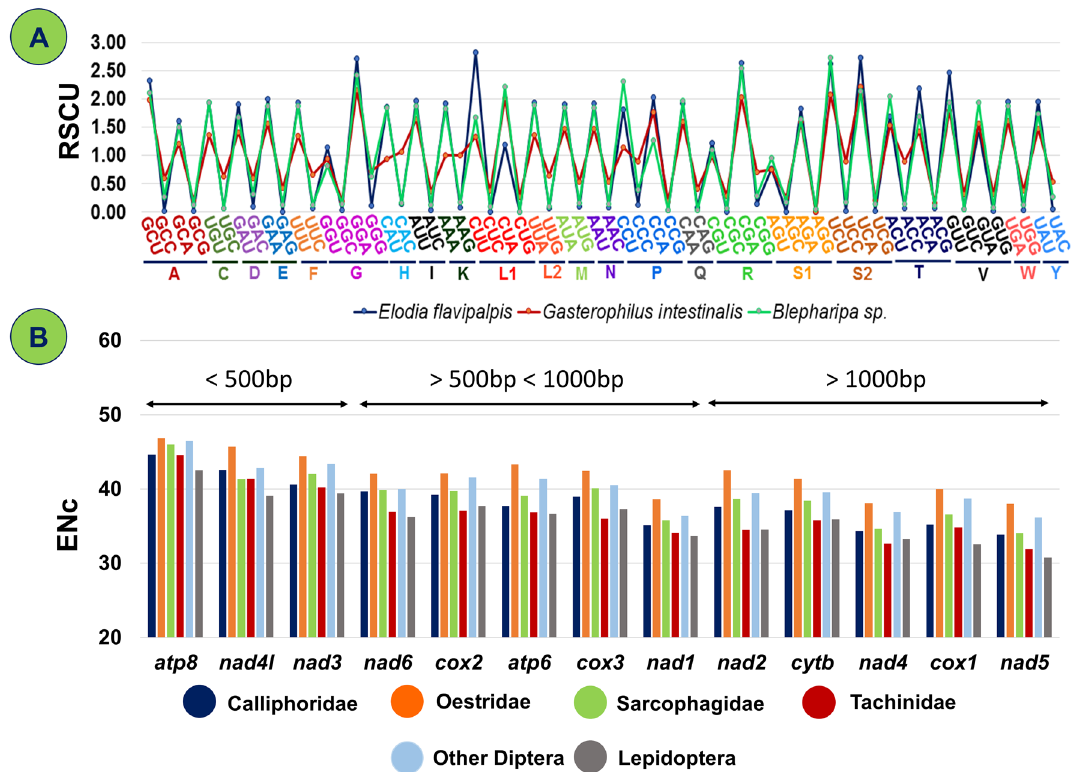
Figure 6. ( A ) RSCU value comparison between E. flavipalpis (Maximum A/U at 3rd codon position), G. intestinalis (Minimum A/U at 3rd codon position) and Blepharipa sp. ( B ) Average Effective codon number (ENc) of 13 PCGs of different families of Oestroidea flies and out